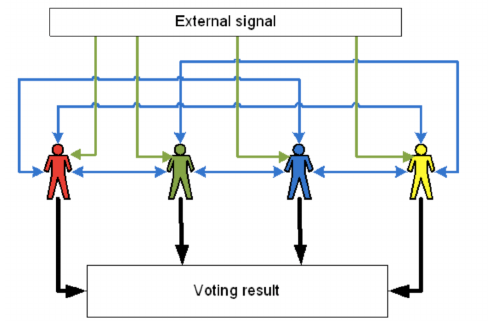
Figure 1: On the existence of feedback in voting authority (for exam- ple, Scientific Council